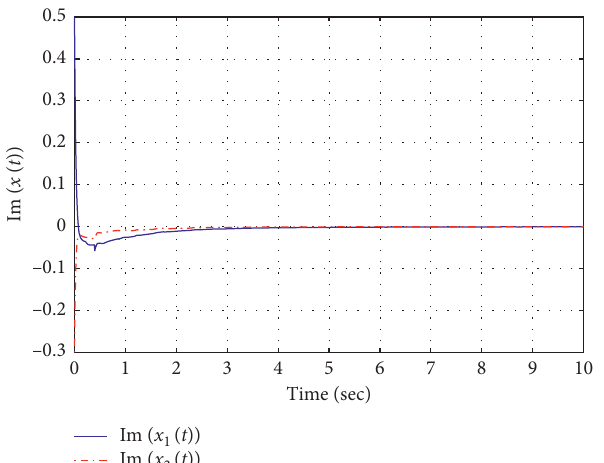
Figure 4: Responses control input u ( t ) of the real part.